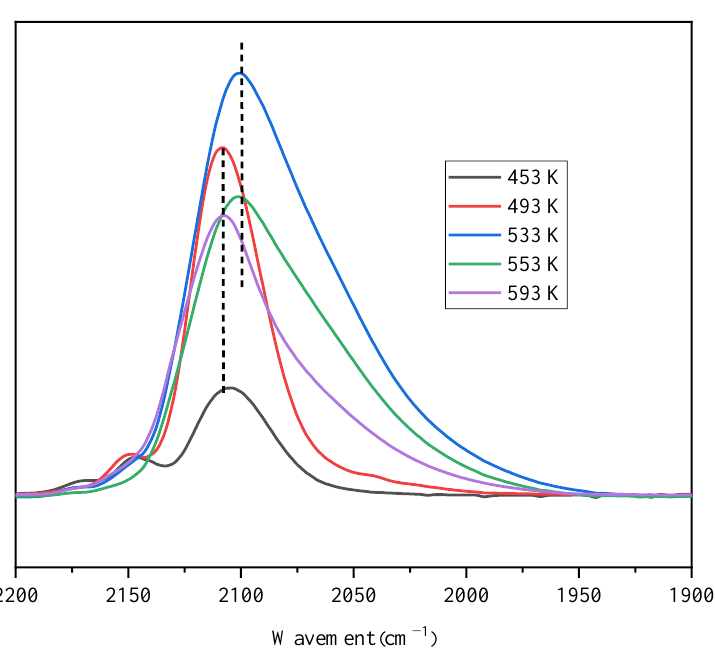
Figure 7. In situ FTIR of the adsorbed CO method using CMA-L catalysts reduced at 454–593 K. According to Vannice et al.’s work [45], partial peaking fitting was carried out. Table 5 displays the relative proportions of Cu species with various valences and the calculated molar ratios of Cu 0 /(Cu 0 + Cu + ). According to Table 5, the proportions of Cu 0 and Cu + increased with reduction temperature, and the Cu 0 /(Cu 0 + Cu + ) ratios rose to around 0.70 between 453 and 553 K, and then fell to 0.60 at 593 K. Cu + could be assigned a band of 2107–2111 cm − 1 , and Cu 0 could be assigned a band of 2080–2094 cm − 1 . The frequencies of Cu 0 were attributed to the different Cu facets [46] or Coppers’ different surface surroundings